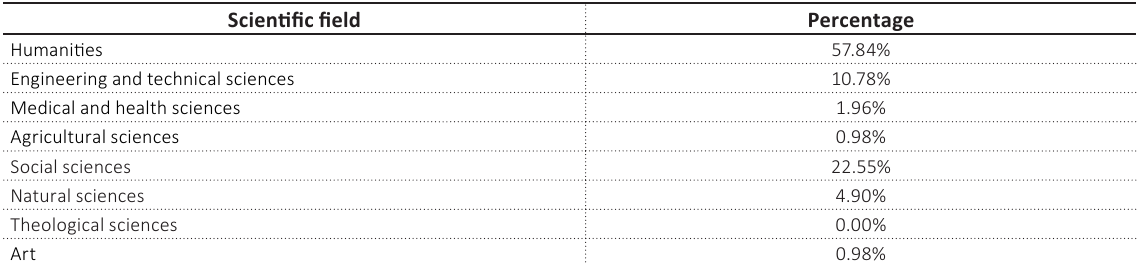
Table 2. Distribution of respondents by education fields